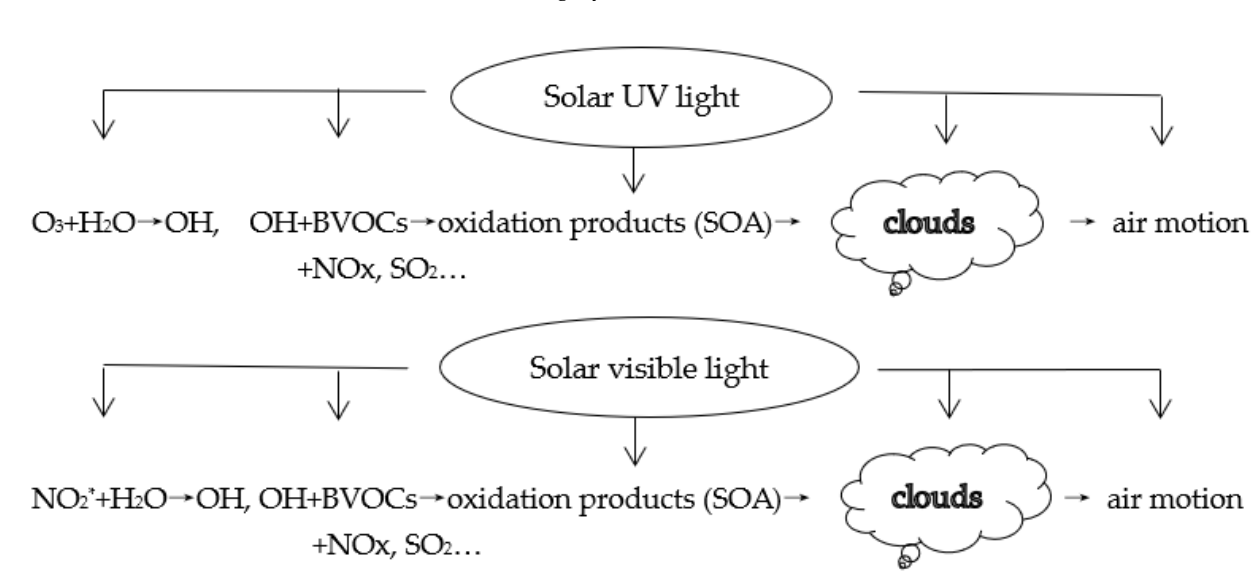
Figure 9. Under solar UV and visible light, OH radical production and chemical and photochemical reactions between OH, BVOCs, SOA and O 3 in gas, liquid and particle phases in the atmosphere. SOA contributes to clouds formation, and then clouds attenuate solar UV, visible and near-infrared radiation and influence the regional radiation balance and air motion. The emissions of BVOCs and their oxidation, along with the above associated potential effects, are interacted with and controlled by UV and visible energy.